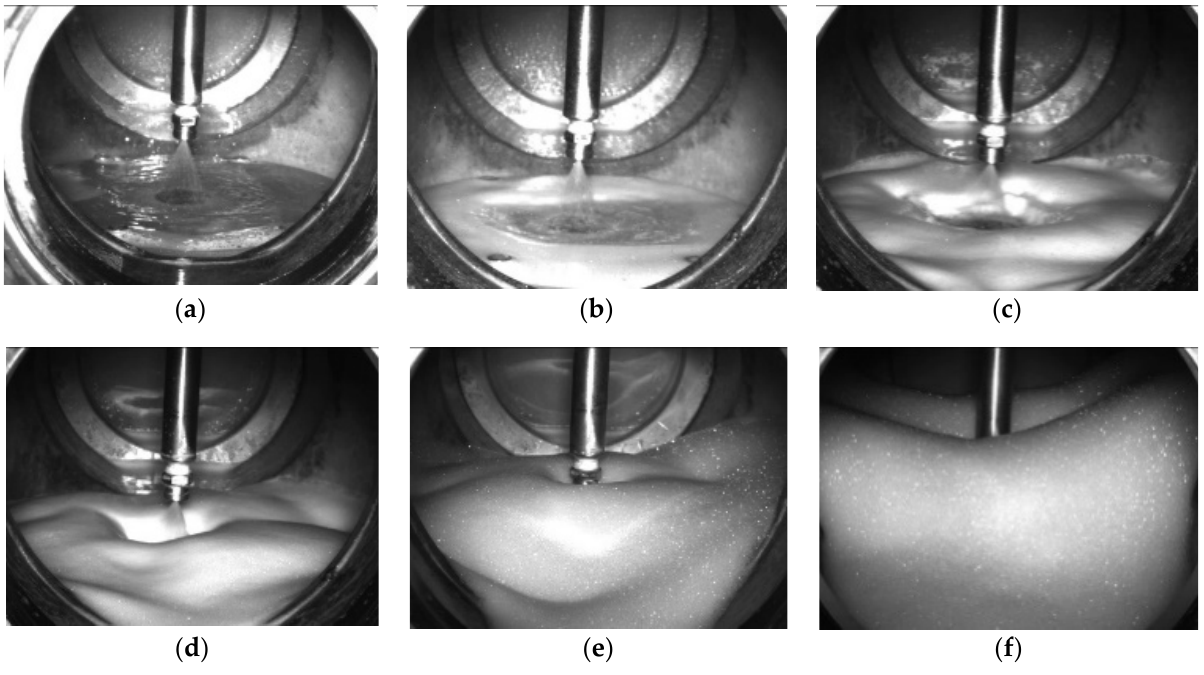
Figure 19. Visualization images of the foam inside the chamber at different CTAB concentrations: ( a ) 50 ppm; ( b ) 100 ppm; ( c ) 150 ppm; ( d ) 200 ppm; ( e ) 250 ppm; ( f ) 300